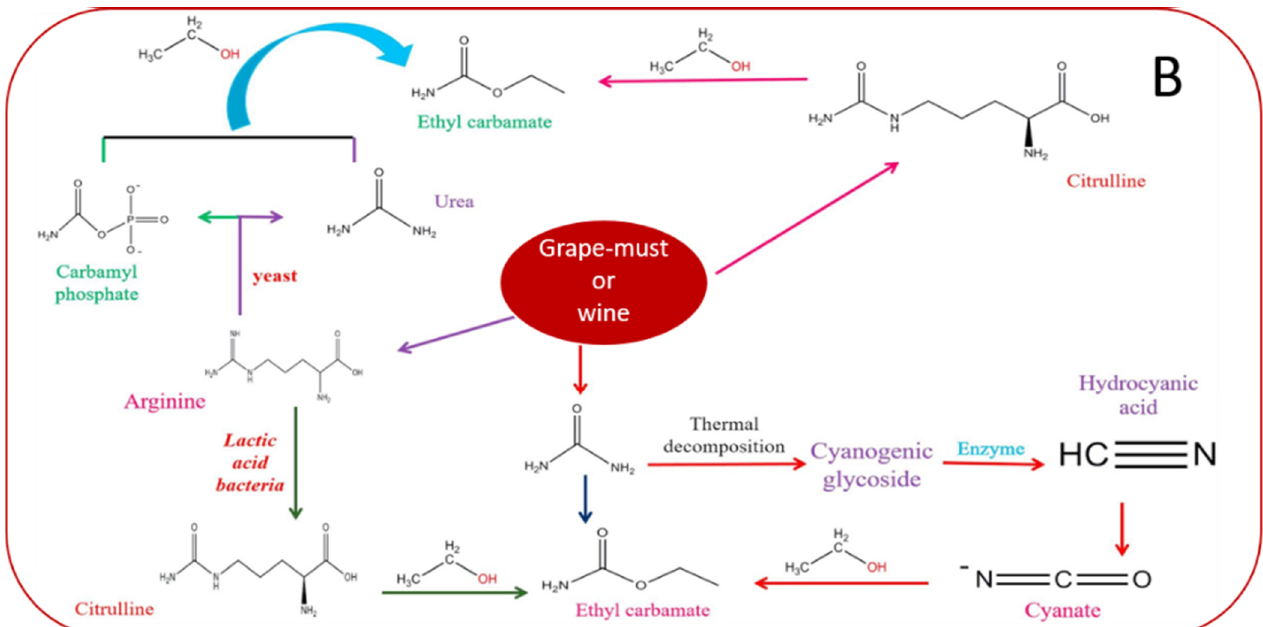
Figure 4. ( A ) Arginine permeases in yeast cells [55] and Saccharomyces cerevisiae S288c Pathway: urea cycle with predicted enzymes and subtracts. Retrieved from https://biocyc.org/YEAST/NEW-IMAGE?type=PATHWAY&object=PWY-4984. Accessed 22 November 2020. ( B ) Precursors and mechanism of ethyl carbamate (EC) formation. The disposal of EC precursors depends on the microorganism present during fermentation. S. cerevisiae degrades arginine to urea and Lactobacilli converts arginine into citrulline. Both compounds react with ethanol producing EC [59].